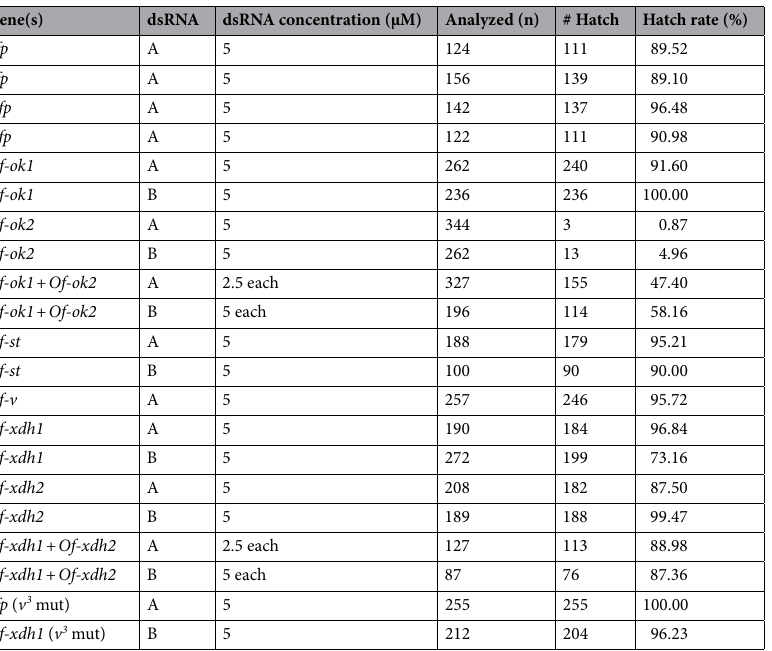
Table 1. Summary of hatch rates observed in pRNAi